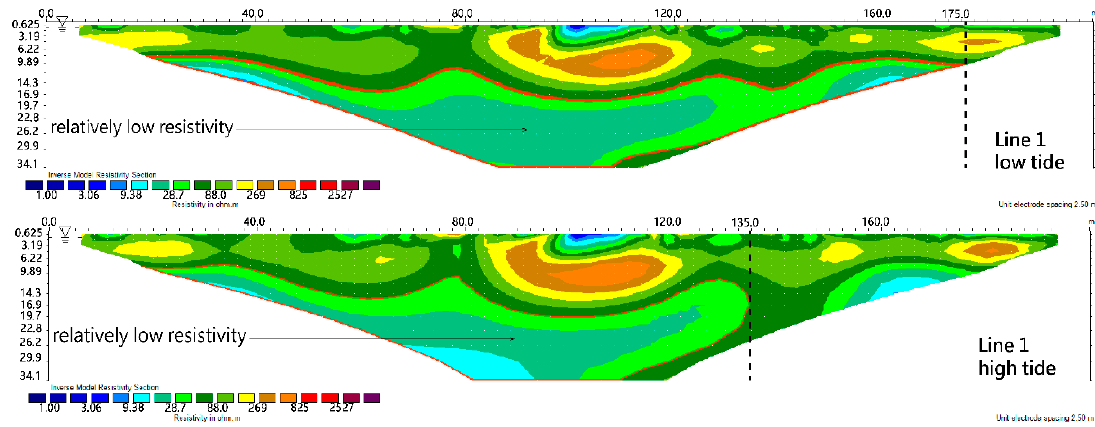
Figure 9. Comparison diagram of tide rising of L1 measuring line (dotted line is front edge of seawater intrusion).